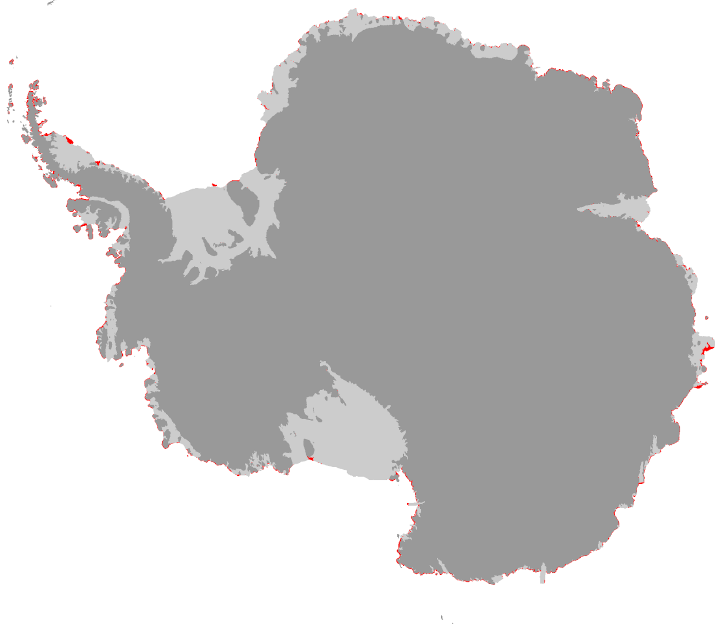
Figure B1. Difference in ice area definition. Red areas show ice that is excluded when imposing ice shelf boundaries from the MEaSURES Antarctic boundaries dataset (Mouginot et al., 2016) onto the ice draft from Bedmap2 (Fretwell et al.,